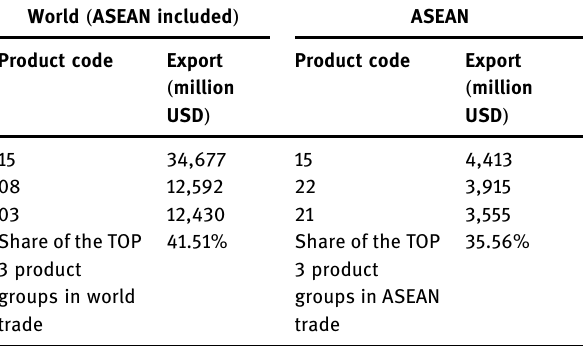
Table 2: TOP 3 agri - food export products of the ASEAN, 2019 World ( ASEAN included )